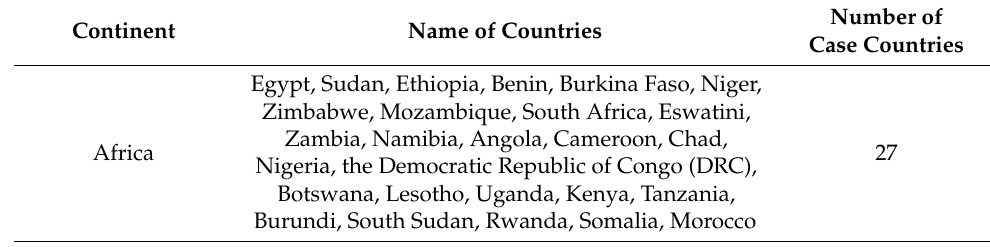
Table 4. Collected case countries at the national